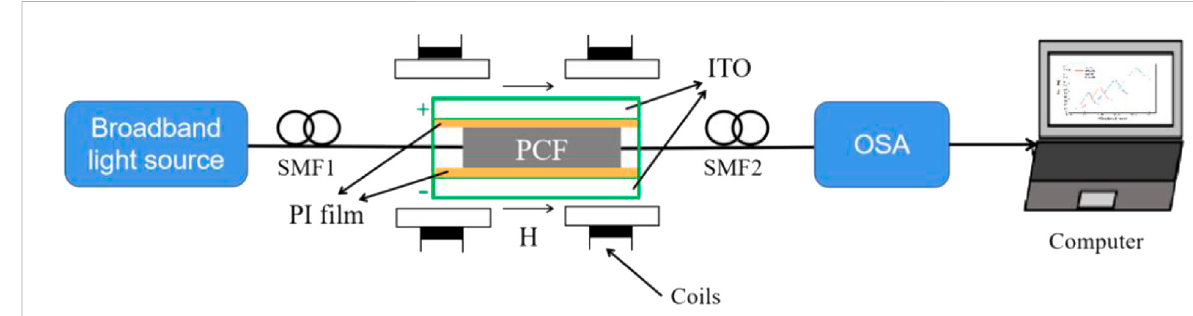
FIGURE 2 Simulation experimental system of the proposed sensing structure.